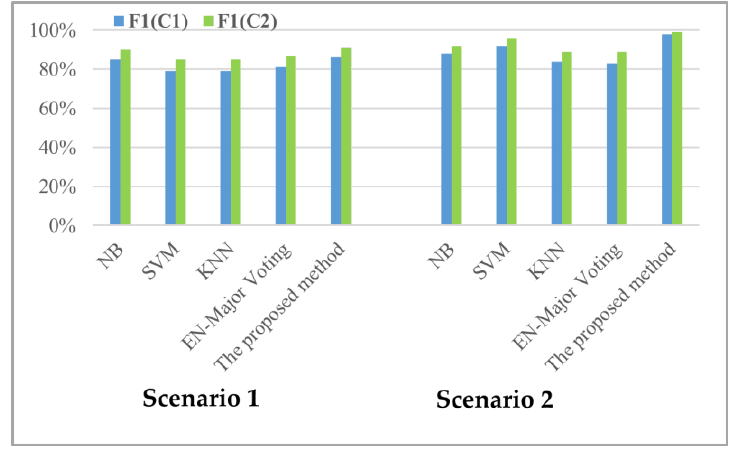
Figure 16. The results of testing the algorithms under two scenarios in the process of fault detection.